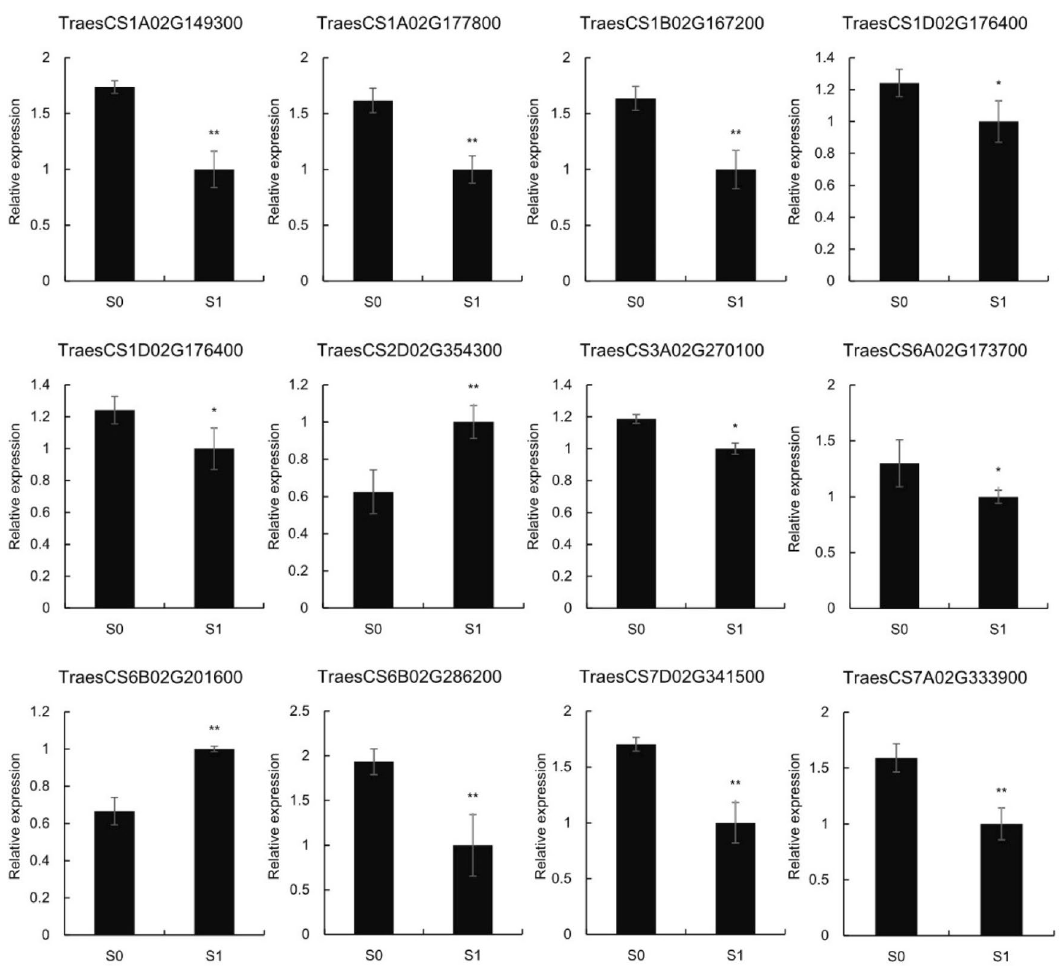
Figure 2. Expression profile of 12 randomly selected differentially expressed genes (DEGs) determined using